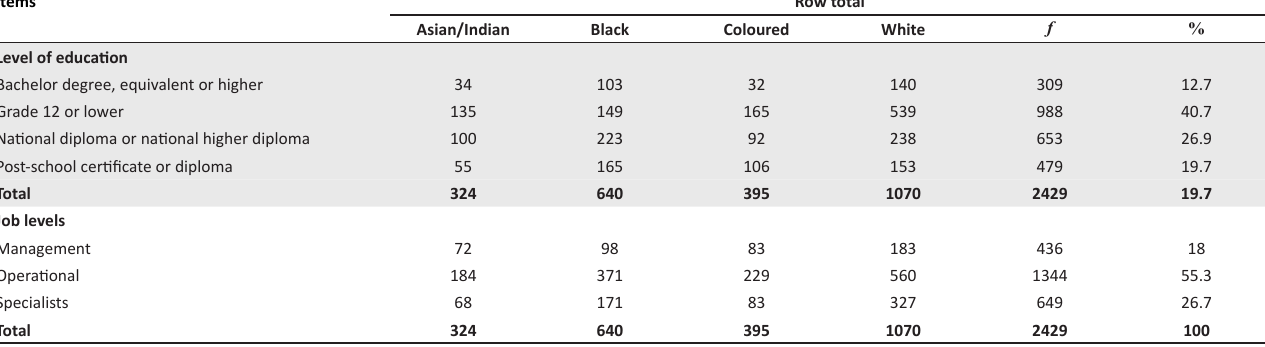
TABLE 2: Cross tabulations between academic qualifications, job levels and cultural groups.